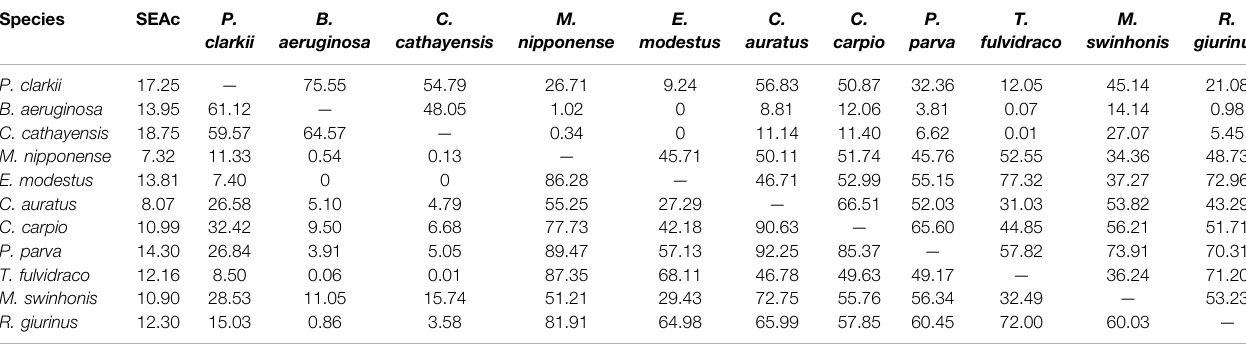
TABLE 4 | The core isotopic niche area (SEAc) and percent overlap (%) between species in Poyang Lake wetland in 2019. Species